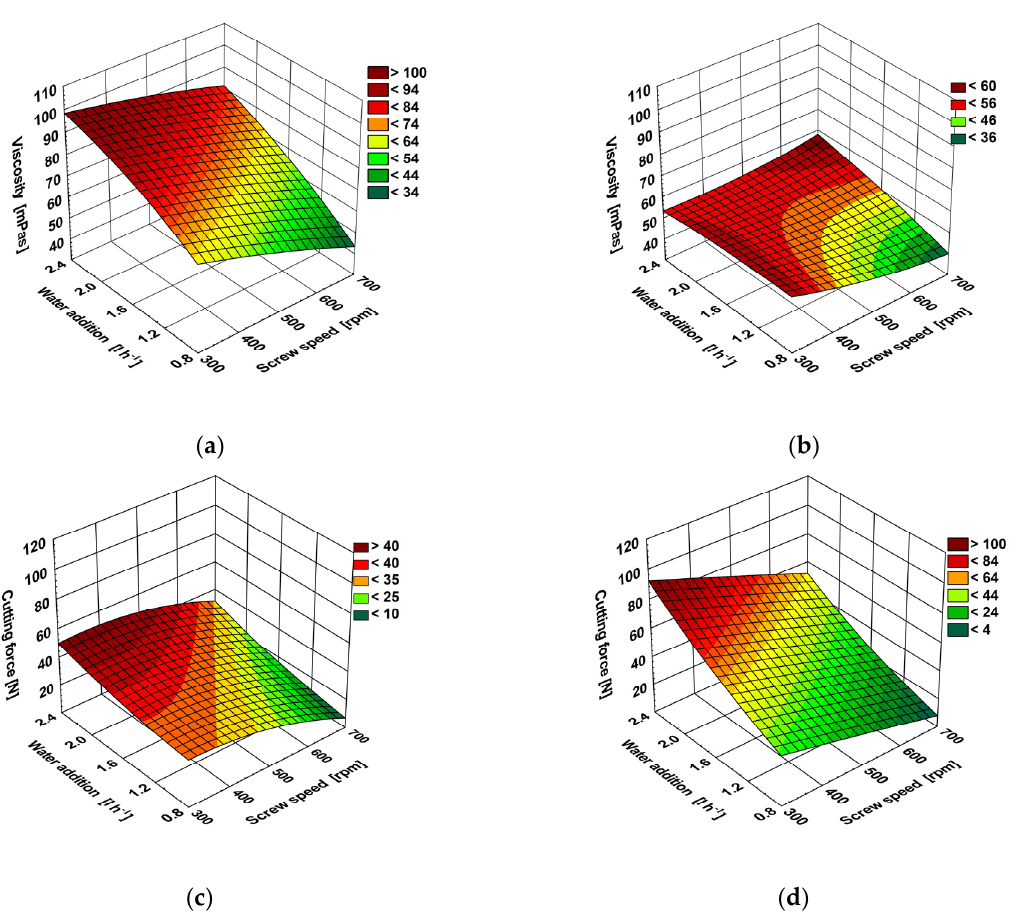
Figure 3. Effect of various extrusion parameters on viscosity and cutting force changes of extruded red beans ( a , c ) and white beans ( b , d ).